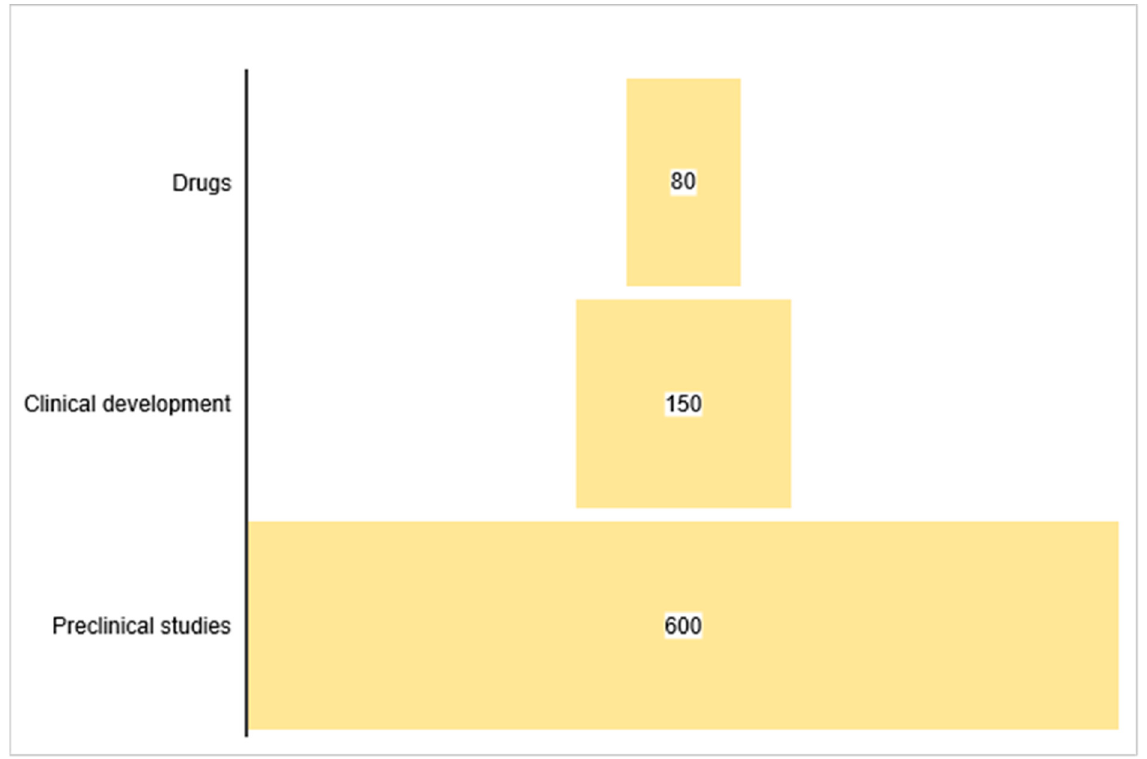
Figure 3. Total number of peptide-based drugs in different stages of drug discovery and development.